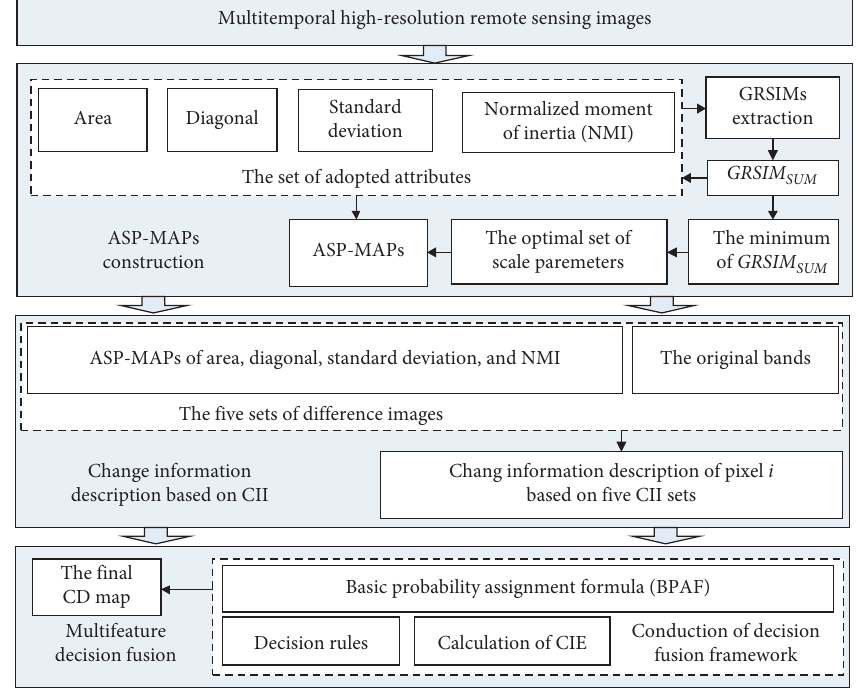
Figure 1: Flowchart of the proposed